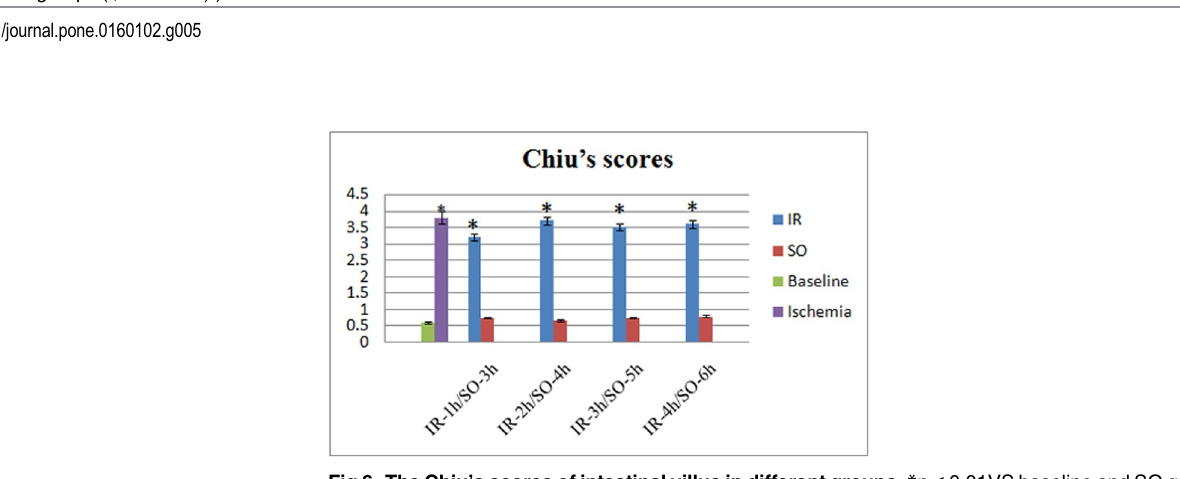
Fig 6. The Chiu ’ s scores of intestinal villus in different groups. * p < 0.01VS baseline and SO